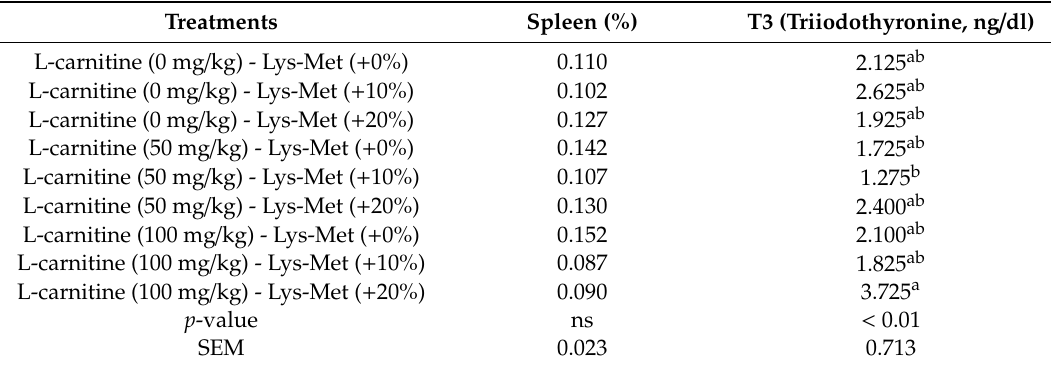
Table 8. Immunity and hormonal parameters of broilers fed di ff erent levels of L-carnitine and lysine-methionine